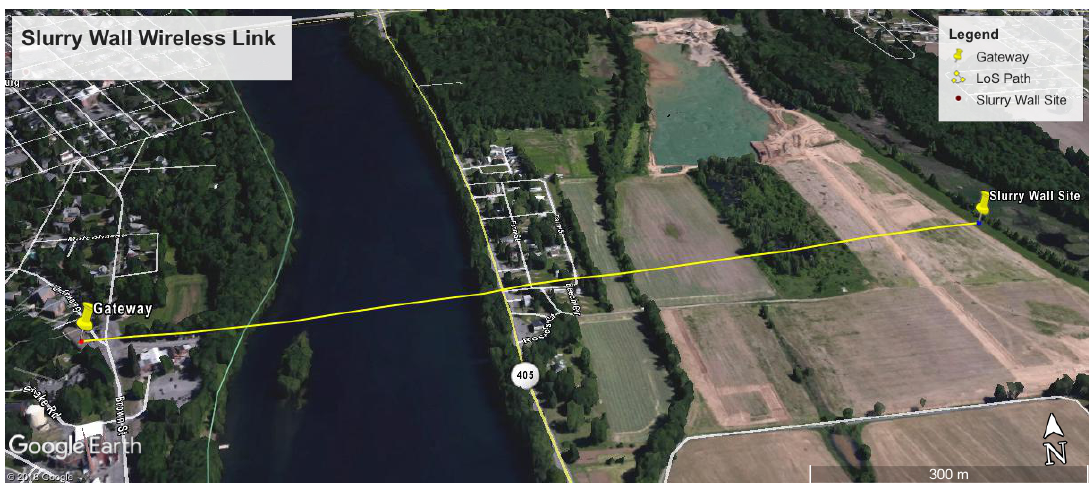
Figure 5. Google Earth rendering of the 1.3 km wireless link from campus to the test site (Google